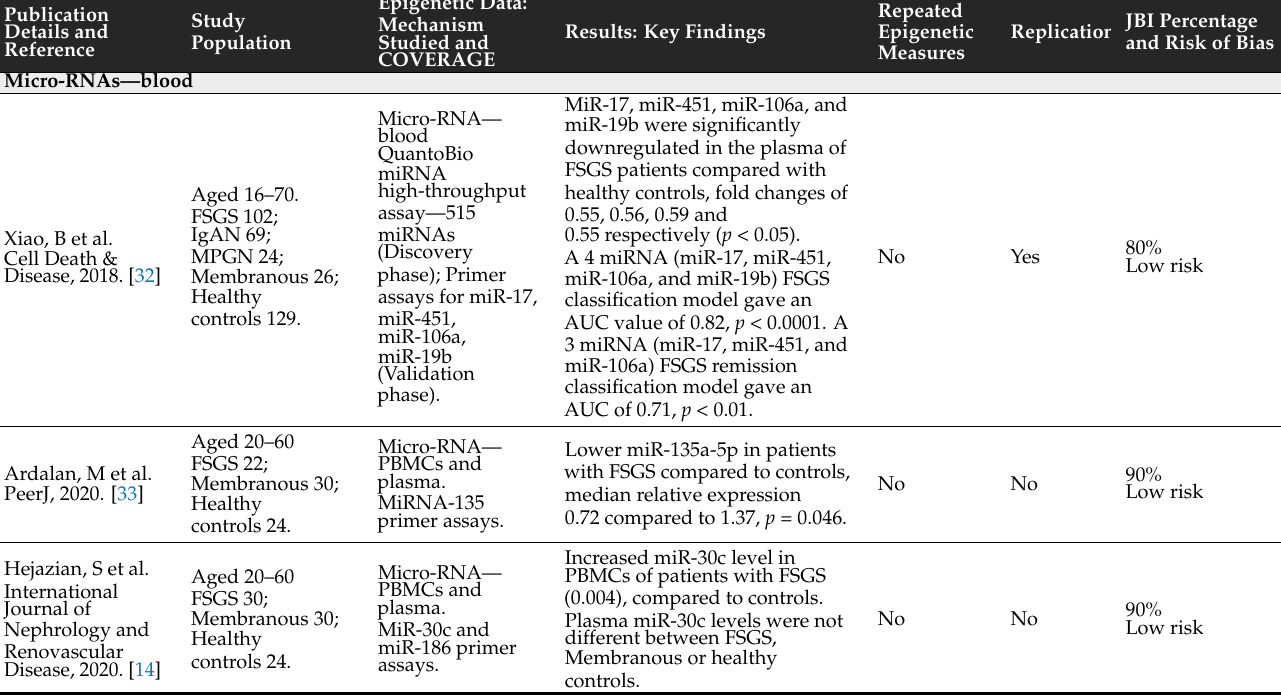
Table 2. Summary of the higher quality micro-RNA